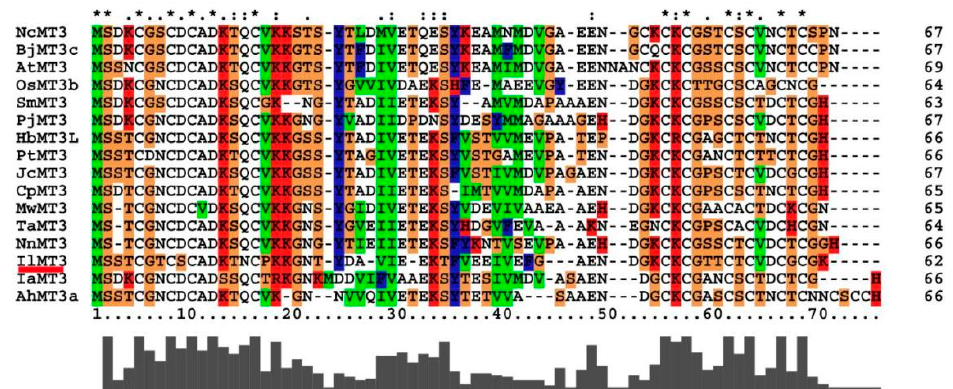
Figure 2. Multiple alignment of the IlMT3 amino acid sequence with sequences from different species.